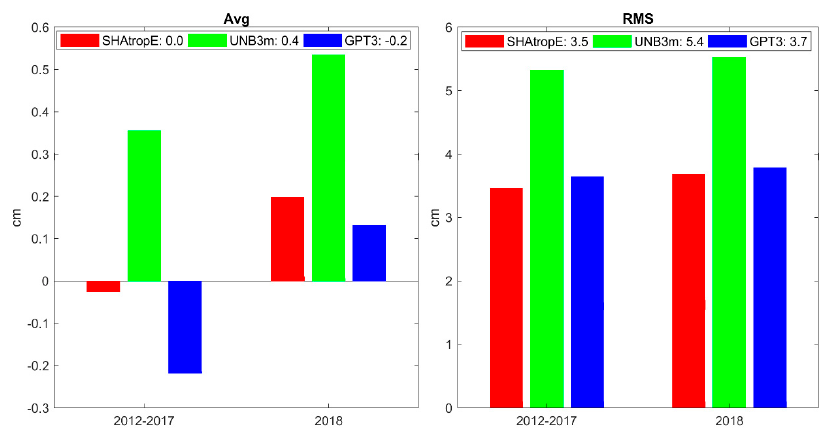
Figure 8. Mean values ( left panel ) and RMS values ( right panel ) of the ZTD bias for the three different models: SHAtropE (red), UNB3m (green), and GPT3 (blue). The statistics of two periods: 2012–2017 and 2018 are presented separately, and the value of the whole period is presented in the legend.